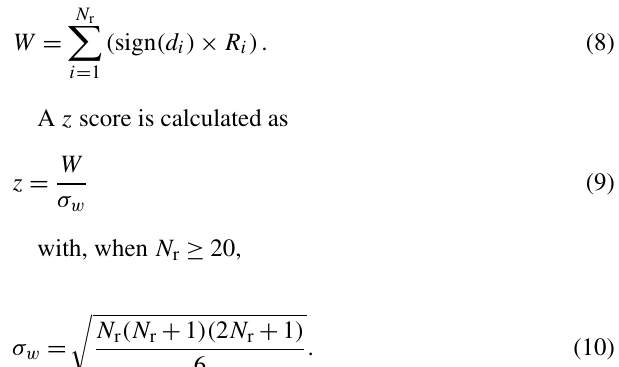
Figure 4. Observed and modelled mean vertical profiles of wind speed (in ms − 1 ) and relative humidity (RH in %) averaged of all profiles over the period 1–31 July 2016 at Abidjan in Côte d’Ivoire (green line), Accra in Ghana (blue line), Cotonou in Benin (purple line), Savè in Benin (orange line), Lamto in Côte d’Ivoire (red line) and Parakou in Benin (brown line). The mean and standard devia- tion at the four locations are represented by the black line and the gray shading, respectively. Outputs from the WRF model are inter- polated along the radiosonde positions. The right panel presents the (mod–obs) mean vertical bias at each location and the average of the four locations. The dashed line materializes the boundary between negative and positive